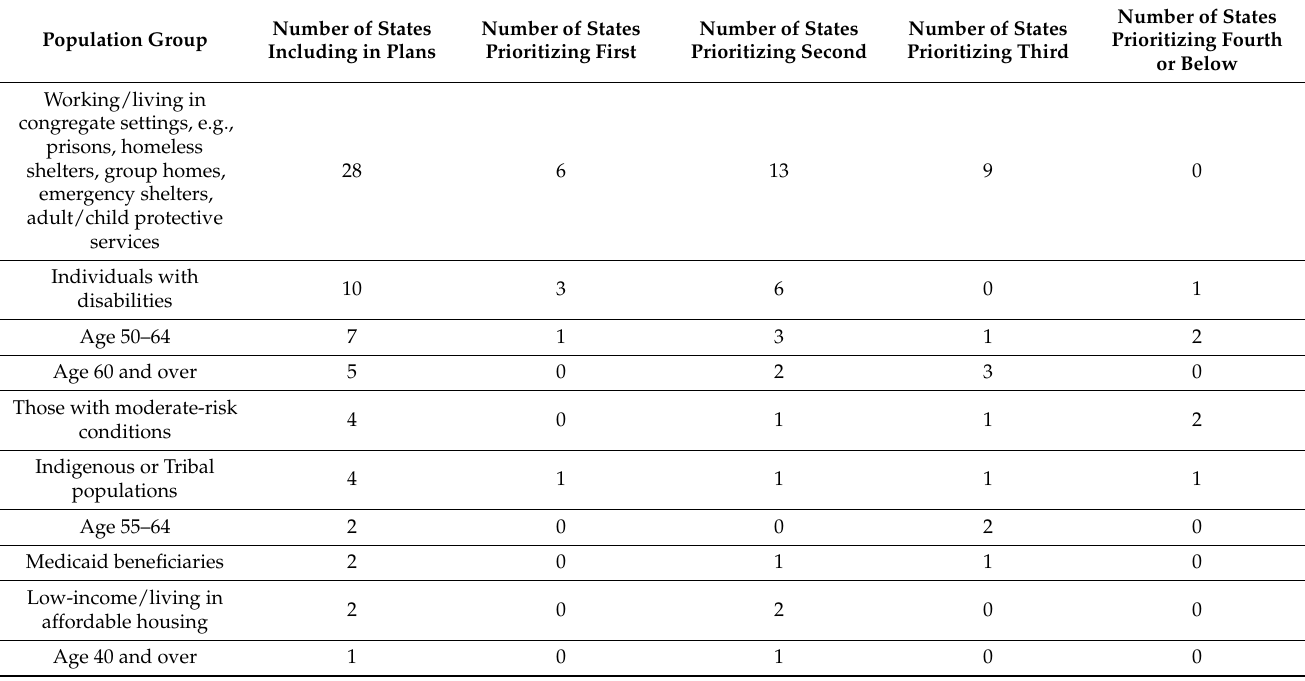
Table 3. Other population groups prioritized by